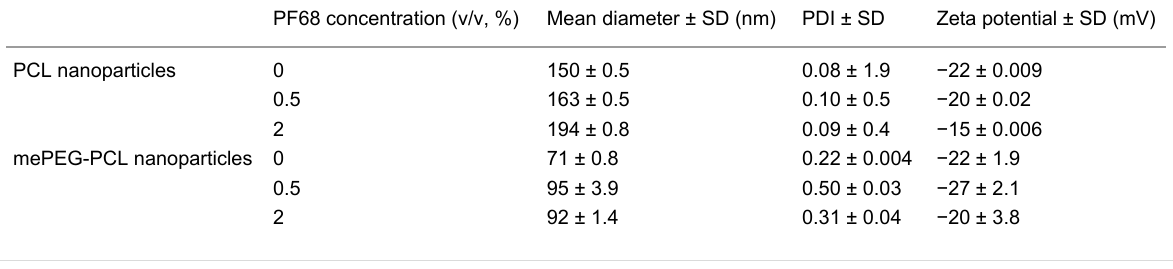
Table 2: The effect of different preparation methods on the physicochemical properties of blank PCL and mePEG-PCL nanoparticles ( n = 3 ± SD).